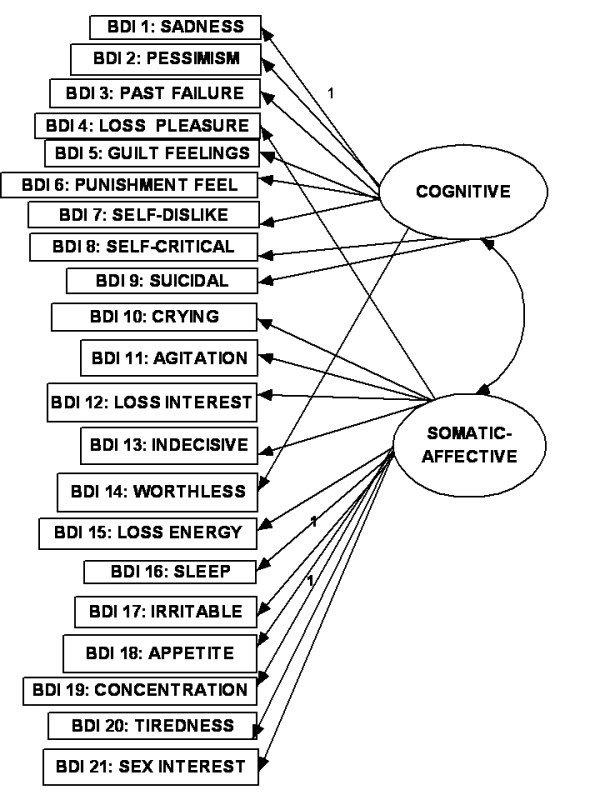
Somatic-affective/cognitive model.